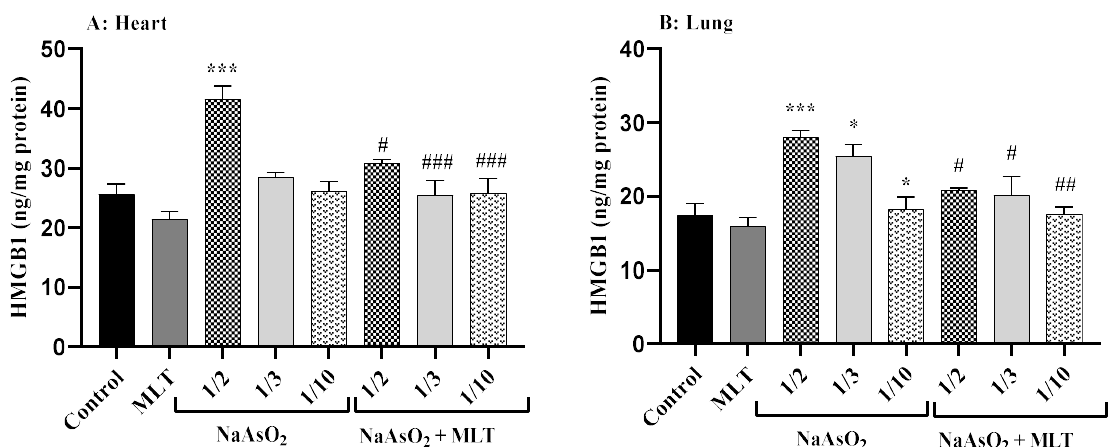
Figure 2. Assessment of High Mobility Group Box 1 (A) High Mobility Group Box 1 levels in heart; (B) High Mobility Group Box 1 levels in lung Abbreviations: HMGB1: High Mobility Group Box 1; MLT; melatonin, NaAsO2; sodium arsenite; Results are expressed as mean ± SEM for five animals in each group (n = 5). *** p < 0.0001; * p < 0.05 (Vs. control or melatonin). ### p < 0.0001; ## p < 0.001; # p < 0.05 (Vs. ½ LD50 NaAsO 2 ).